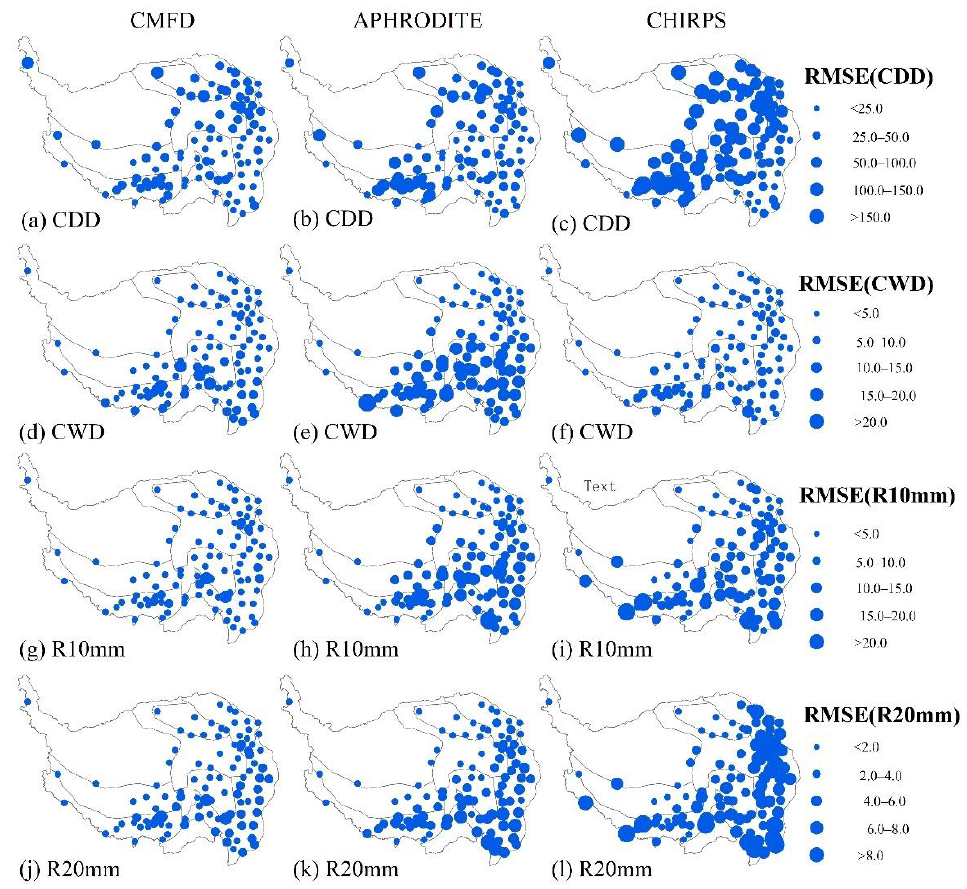
Figure 6. RMSE for gauge-based fixed threshold indices CDD, CWD, R10mm, and R20mm, as derived from CMFD, APHRODITE, and CHIRPS for the period 1981 – 2014.